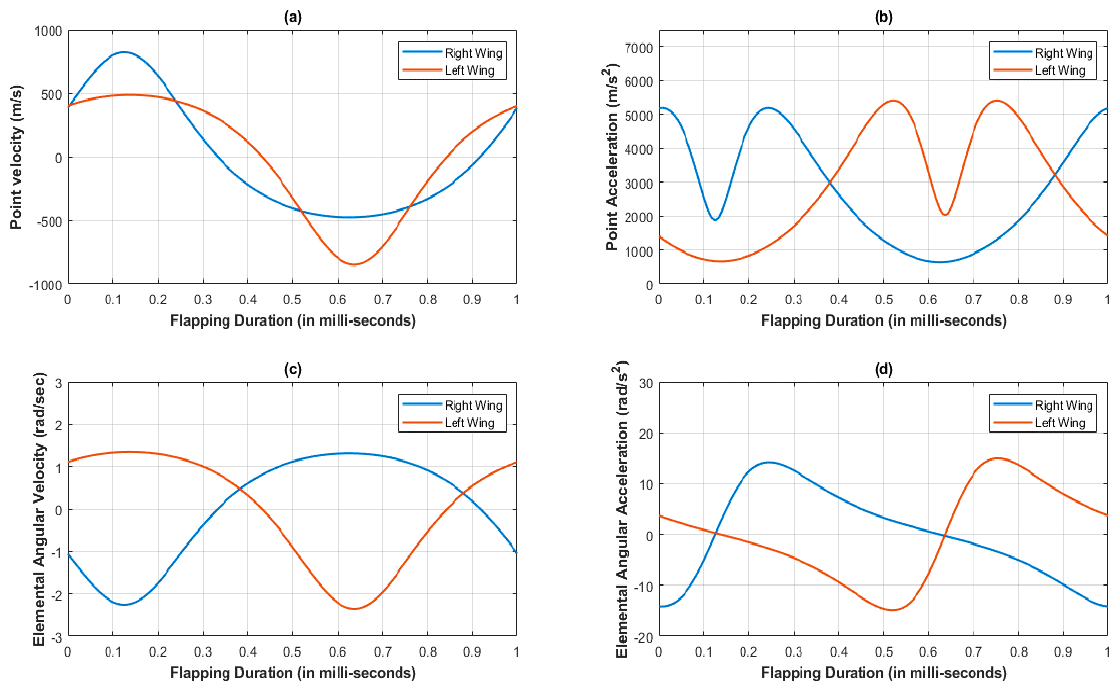
Figure 10. Kinematic analysis at the lever tip of SC-SDL design Mechanism-I; ( a ) Point velocity vs. flapping duration; ( b ) Point acceleration vs. flapping duration; ( c ) Elemental angular velocity vs. flapping duration; ( d ) Elemental angular acceleration vs. flapping duration.